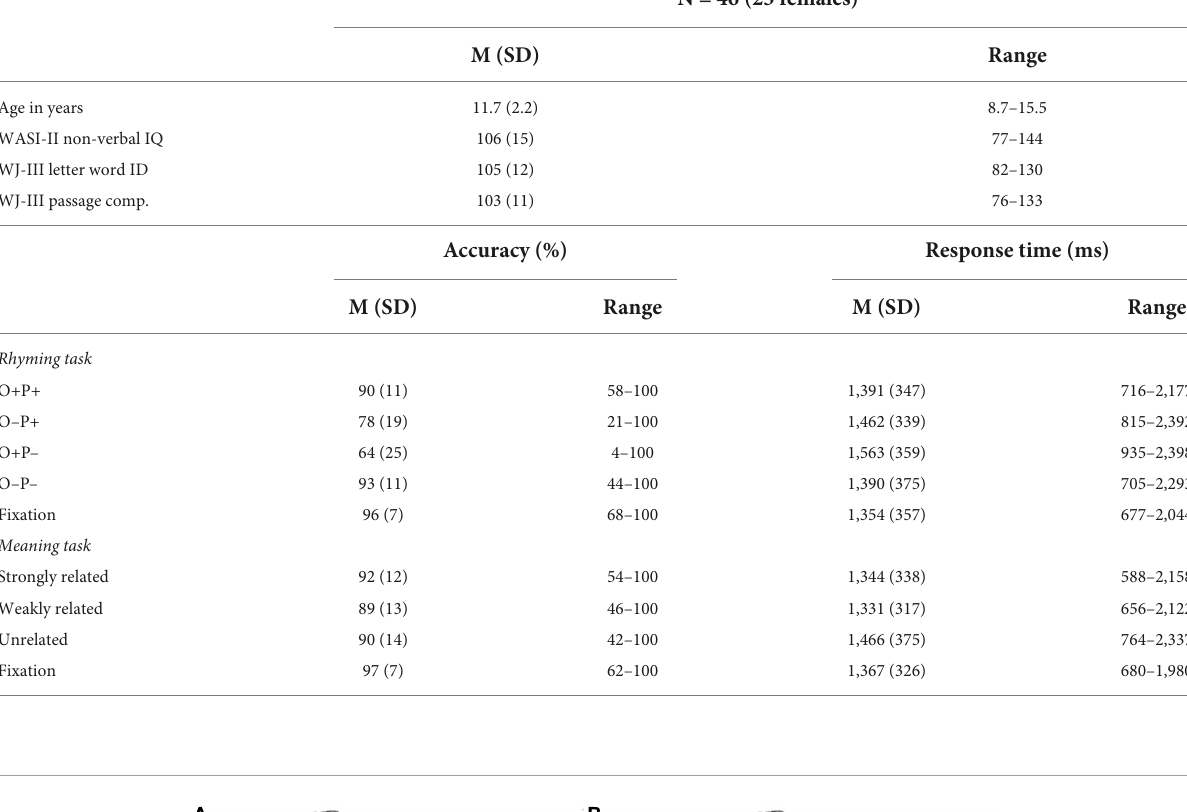
TABLE 1 Participant demographics, standard scores on reading assessments, and behavioral performance during the two functional magnetic resonance imaging (fMRI) tasks.